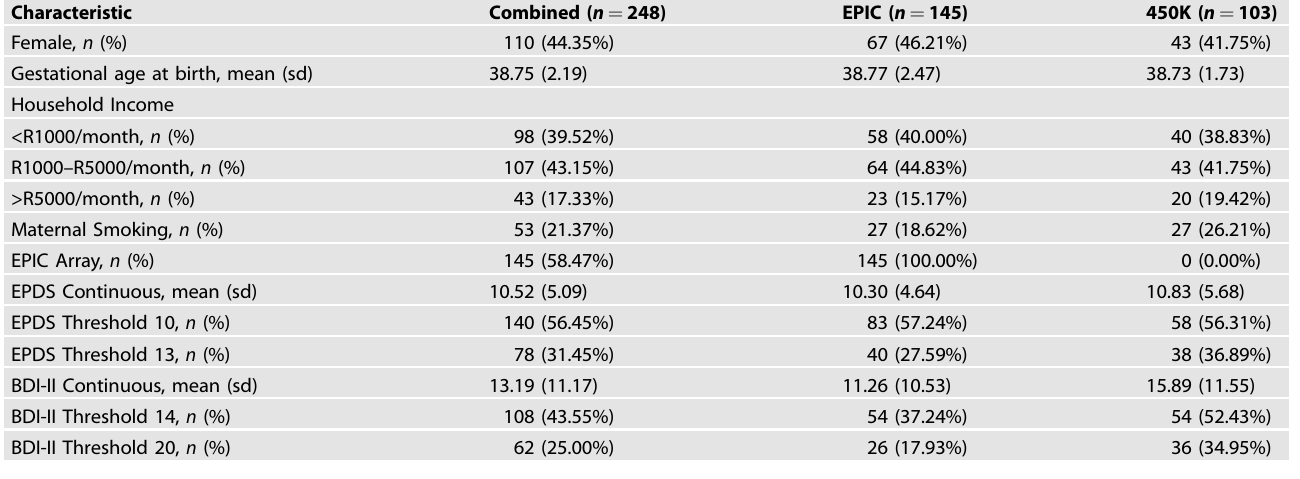
Table 1. Population characteristics for the total population and strati fi ed by arrays.